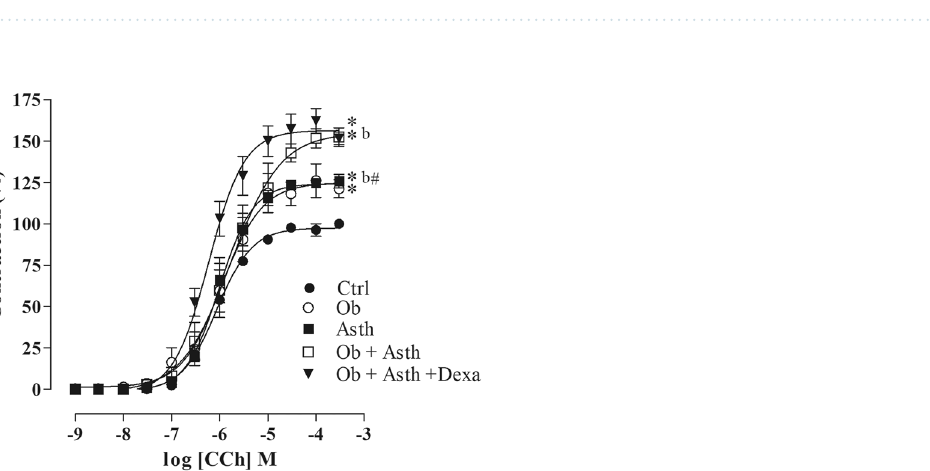
Table 5. E max and EC 50 values of contractile and relaxant agents in the Ctrl, Ob, Asth, Ob + Asth and Ob + Asth + Dexa isolated rat trachea groups. One-way ANOVA followed by Tukey’s posttest (n = 4–6). * p < 0.05 (Ctrl vs. Ob, Ob + Asth).